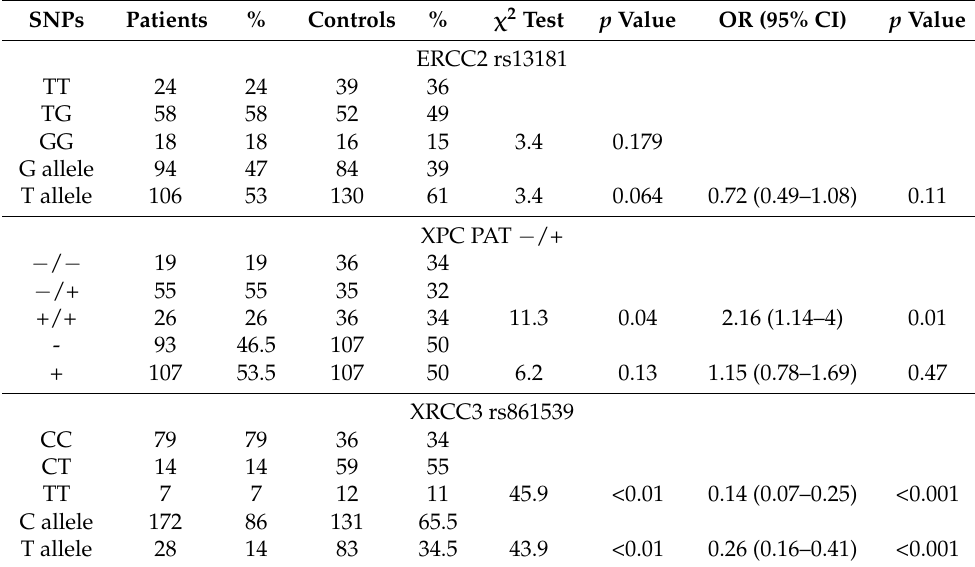
Table 2. Frequencies of studied DNA repair gene SNPs in patient and control groups.